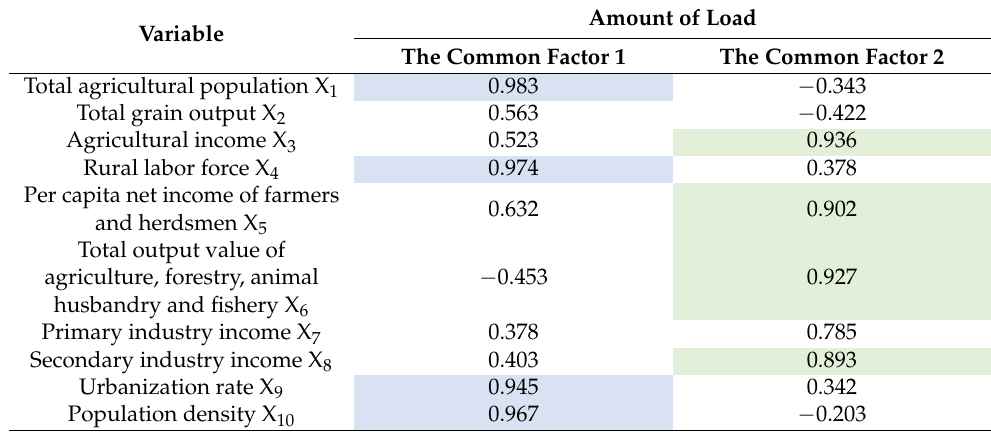
Table 6. Selection of explanatory